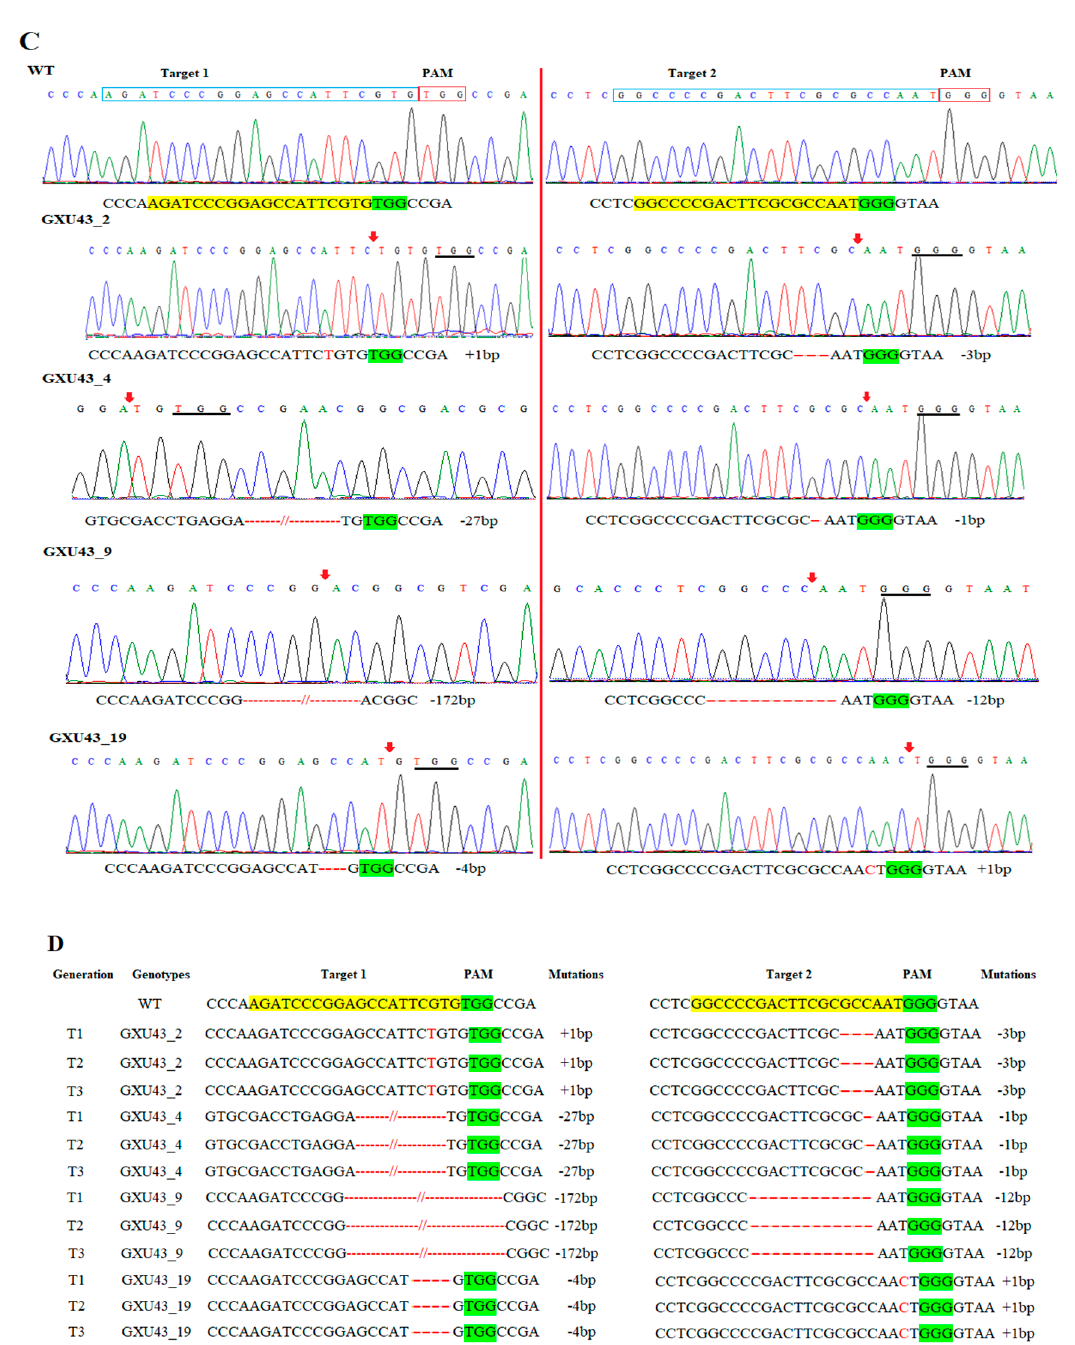
Figure 1. Identification of mutations generated by the clustered regularly interspaced short palindromic repeats/CRISPR-associated protein 9 (CRISPR/Cas9) system. ( A ) The mutation efficiency of sgRNAs (single guided RNAs), ( B ) The mutation rate in T 0 (Transgenic) generation, ( C ) sequencing chromatograms of WT (wild type) and homozygous mutant lines for Target 1 and Target 2, and ( D ) the alignment of sequences for T 1 , T 2 , and T 3 generations, respectively. The target sequence is painted in yellow, while the PAM (protospacer adjacent motif) is in the green background, and insertions/deletions are represented by red hyphens and letters. The analysis was carried out in three replications for each line.